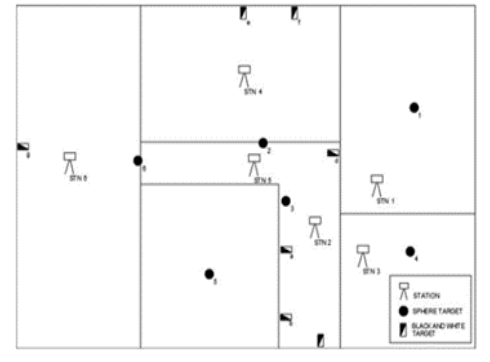
Figure 5. Position of the scanner and targets during data